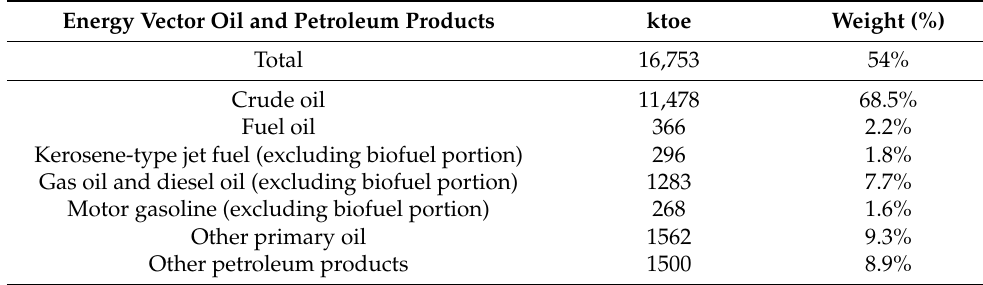
Table 1. Energy and weight of each energy vector in Portuguese energy mix available from oil and petroleum products in 2019 (from Eurostat